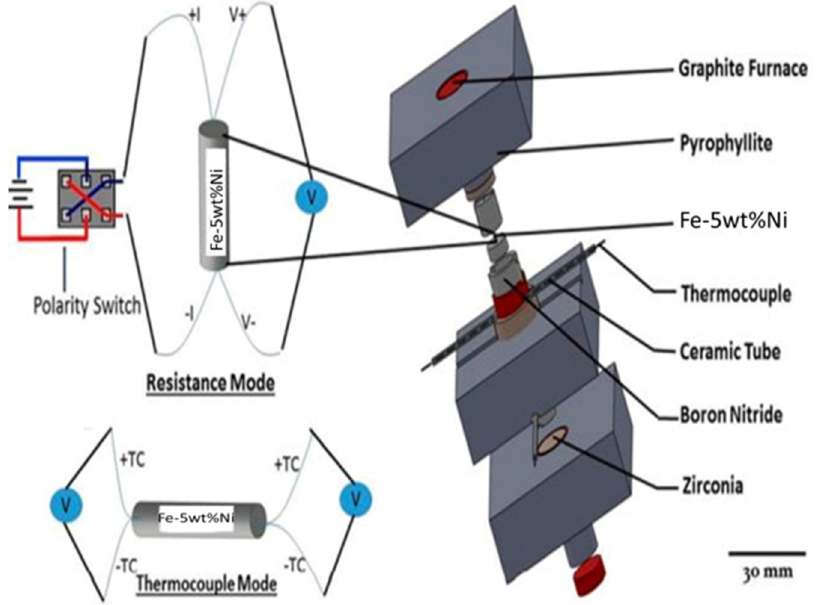
Figure 1. Schematic diagram of cell design (modified from Ezenwa and Secco [26]).